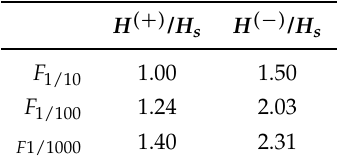
Table 2. Virtual wave heights H (+) and H ( − ) on a vertical wall ([14]).